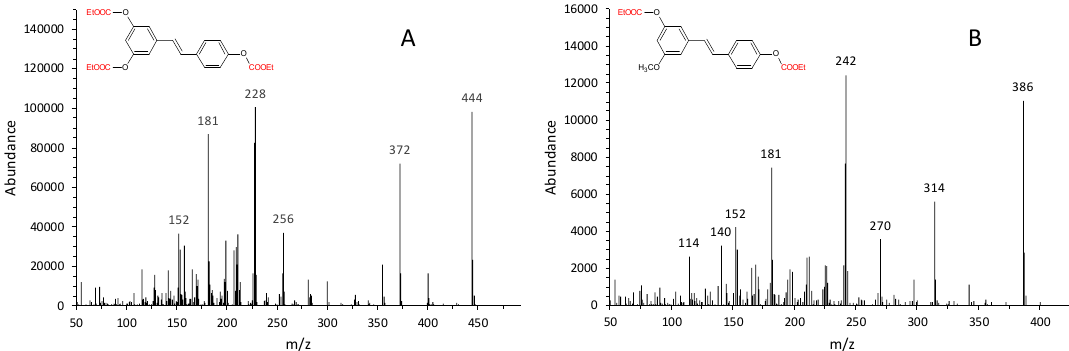
Figure 4. Electron ionization (EI) mass spectra of ( A ) trans / cis -resveratrol as tri-ethoxycarbonyl derivatives (the isomers show an identical fragmentation pattern) and ( B ) pinostilbene as di-ethoxycarbonyl derivative (internal standard).